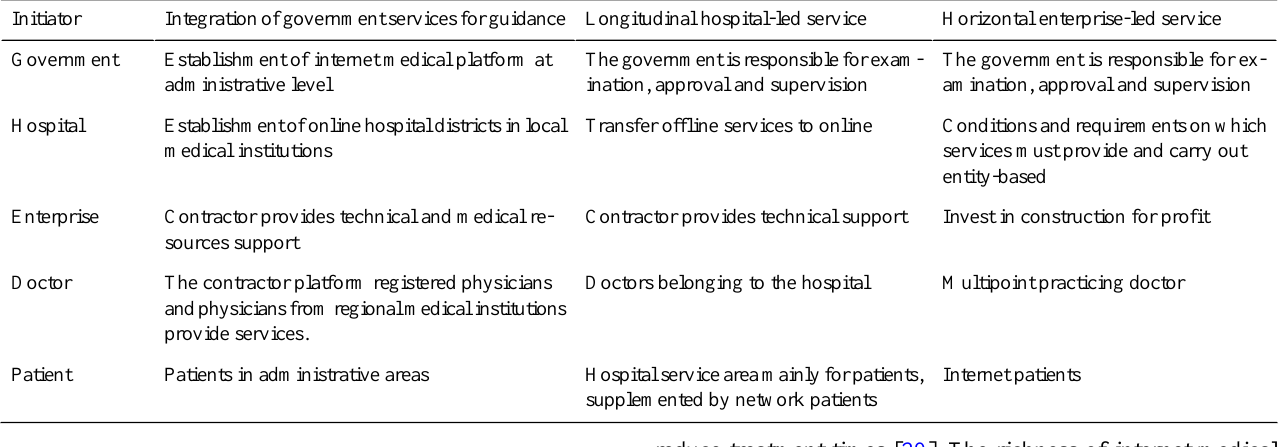
Table 3. Relevant parties of internet hospital